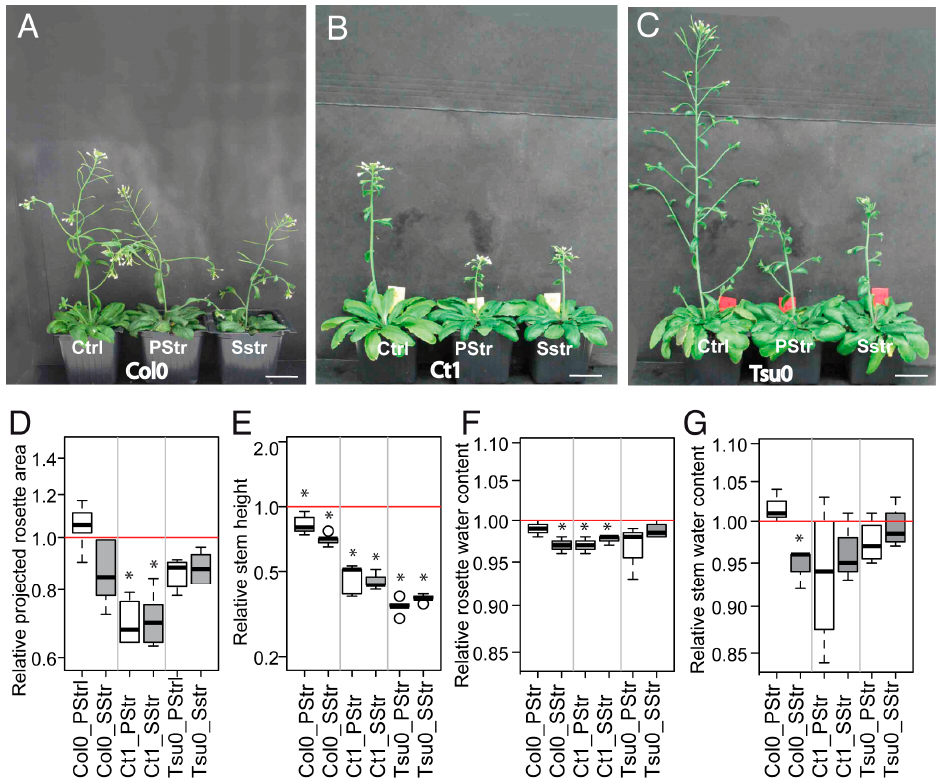
Figure 4. Physiological responses to salt treatment in Arabidopsis accessions. ( A – C ) Plant growth at 17 DAB under Ctrl, PStr, and SStr treatments, for the Col0 ( A ), Ct1 ( B ), and Tsu0 ( C ) plants. Scale bar = 2.5 cm. ( D – G ) The box and whisker plots represent the distribution of the biological replicates (see Figure 2 for details) within the ( D ) fold-changes in the projected rosette area at 17 DAB ( n = 5–6), ( E ) the fold-changes in the stem height at 17 DAB ( n > 6), ( F ) the fold-changes in rosette water content at 16 DAB ( n = 4), and ( G ) the fold-changes in the stem water content at 16 DAB ( n = 4). The fold changes were determined using the values that were normalized to the mean of control plants of the same accession. Red lines indicate the relative control means (= 1). Stars denote significant differences of treatments compared to the control plants (* p < 0.05, n ≥ 5). White bars—PStr plants. Grey bars—SStr plants.